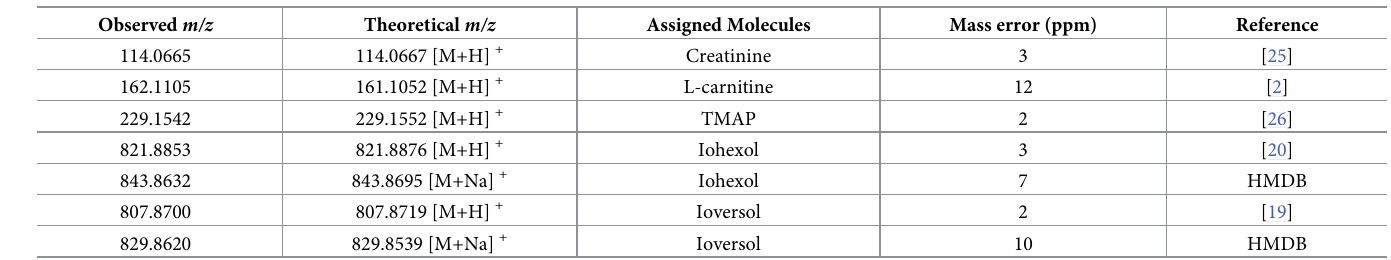
Table 1. List of peaks in the Q-TOF MS obtained from spent hemodialysates. Observed